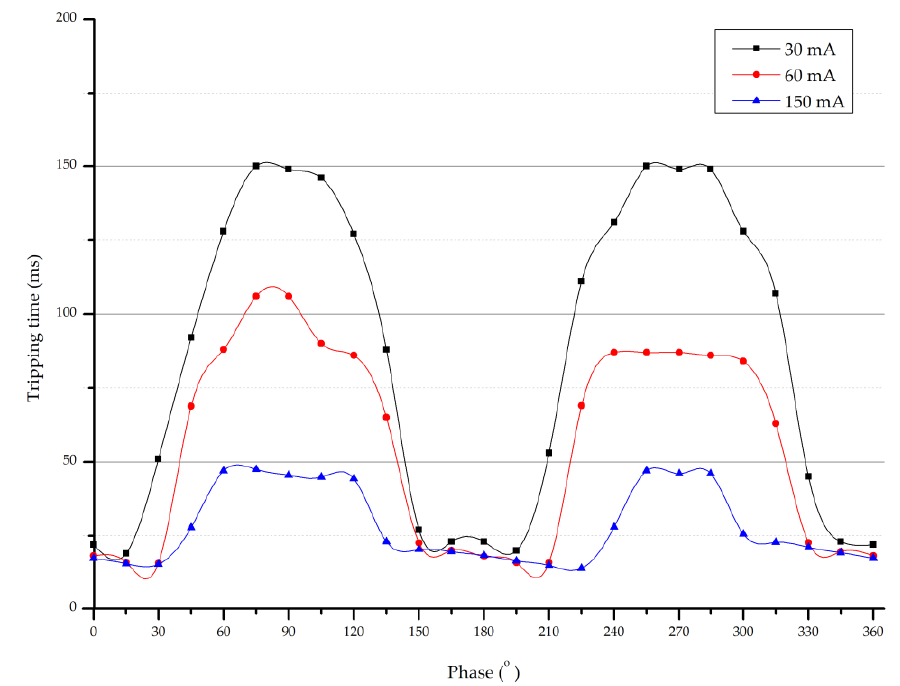
Figure 17. The dependencies of RCD-8 break time versus initial phase of the test current ( I ∆ ), for 30 mA, 60 mA, and 150 mA (50 Hz).